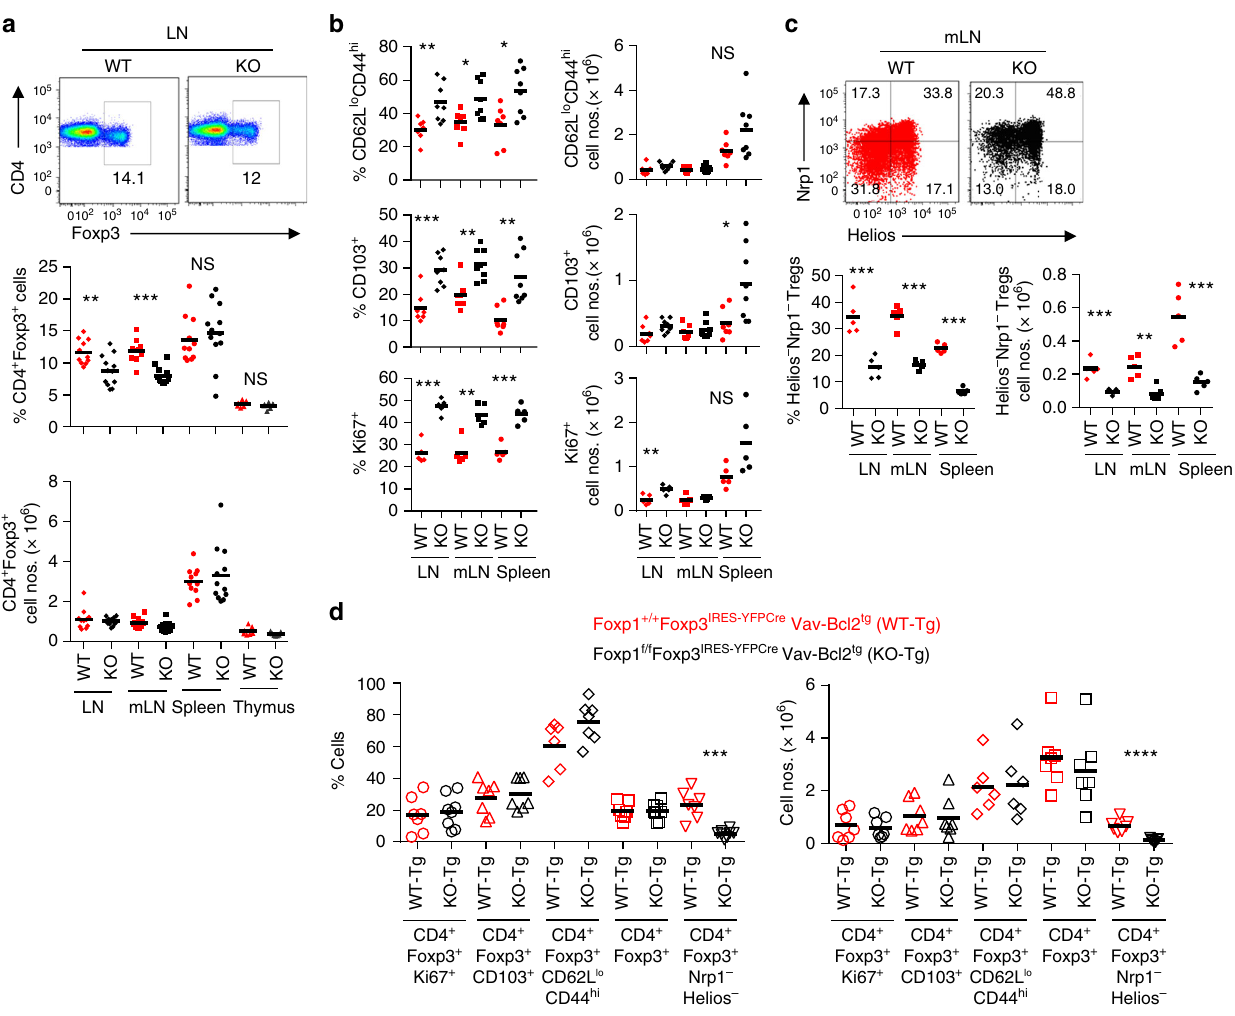
Fig. 6 Reduced iTreg compartment in Foxp1 f/f Foxp3 IRES-YFP-Cre mice. a Representative fl ow cytometric analysis (top), and quanti fi cation of percentage (middle) and absolute numbers (bottom) of CD4 + Foxp3 + Treg cells in the indicated organs of WT and KO mice. b Quanti fi cation of percentage (left) and absolute numbers (right) of Treg activation represented by CD62L lo CD44 hi and CD103 + and proliferation by Ki67 + cells within CD4 + Foxp3 + population. c Representative fl ow cytometric analysis (top) and quanti fi cation (bottom) of in vivo Foxp3 + Nrp1 − Helios − iTreg population within the indicated peripheral lymphoid organs. d Foxp1 f/f Foxp3 IRES-YFP-Cre mice were bred with Vav-Bcl2 tg mice to generate WT-Tg and KO-Tg mice. Expression of the indicated markers as percentage (left) and total numbers (right) in mLN of WT-Tg and KO-Tg are shown. Data are representative of 2 – 4 independent experiments. * P < 0.05, ** P < 0.01, *** P < 0.001, **** P <0.0001 (Student ’ s t test, error